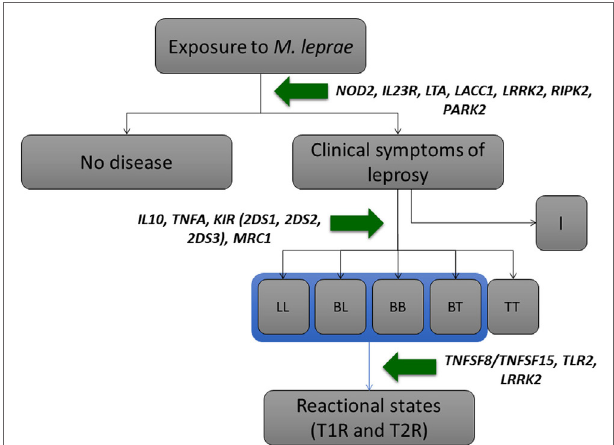
FiGURe 1 | Pathogenesis of leprosy with selected genes impacting on its phenotypes. Adapted from Mira (12) and Sauer et al. (13). For a more detailed list of genes, please refer to Table 1 . Abbreviations: I, indeterminate; LL, lepromatous leprosy; BL, borderline-lepromatous; BB,